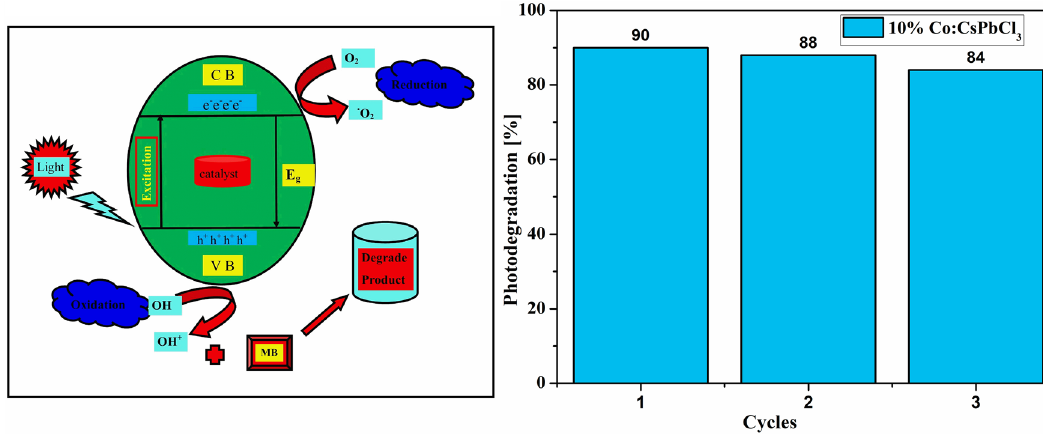
Figure 15. Schematically diagram of photocatlytic process and